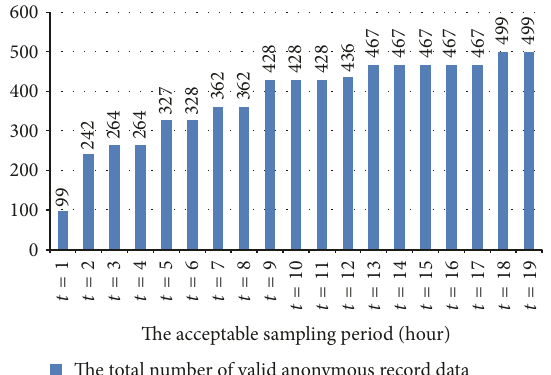
Figure 2: The respective total number of anonymous records at different acceptable sampling periods.